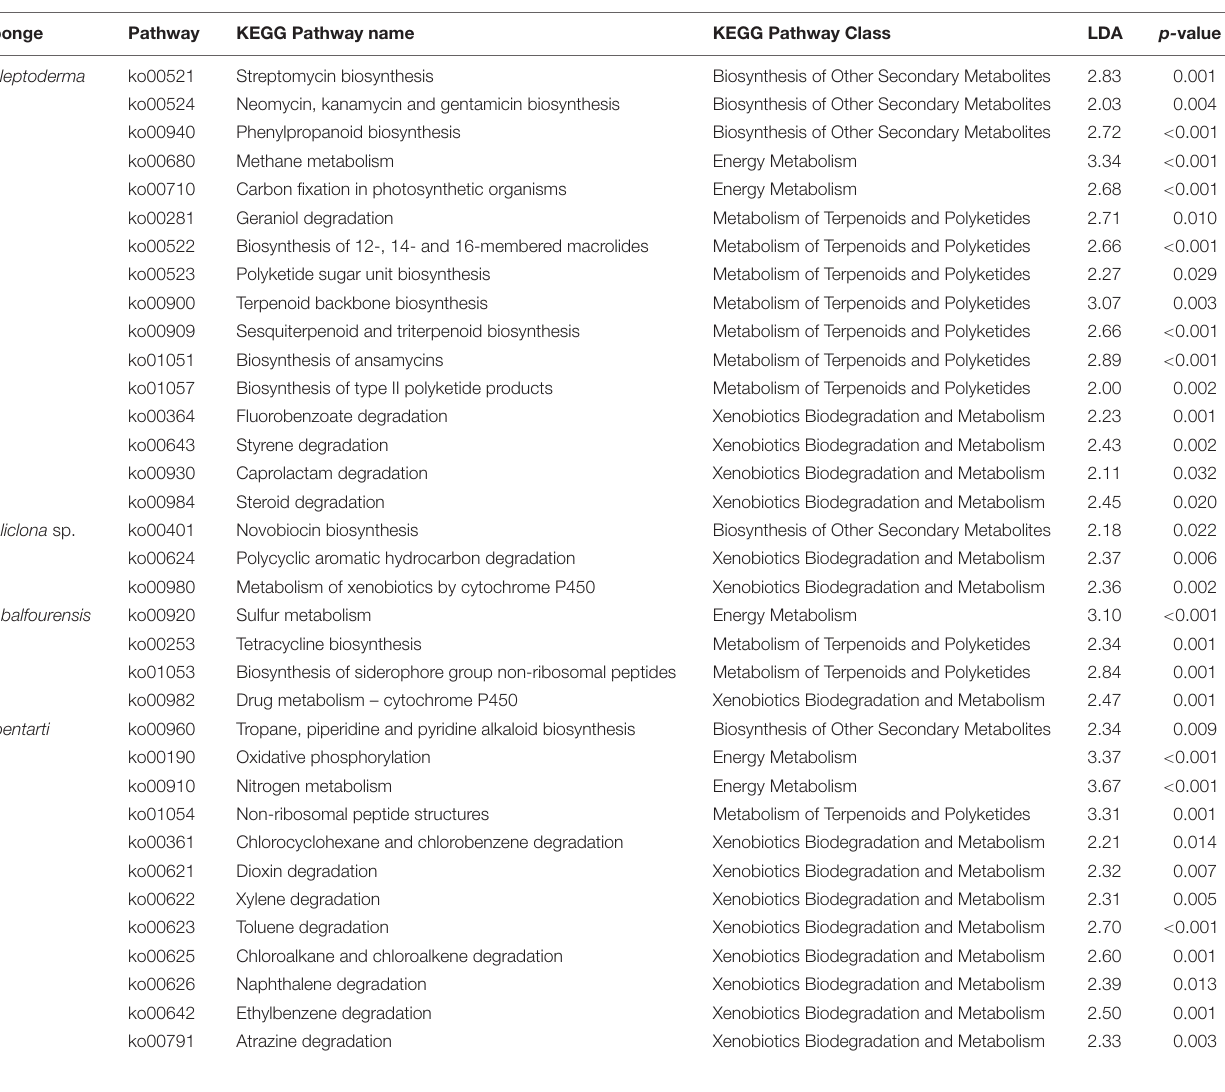
TABLE 2 | KEGG pathways information sorted by sponge taxa with pathway identifier, pathway name and class, the linear discriminant analysis effect size (LDA), and corresponding p -values.